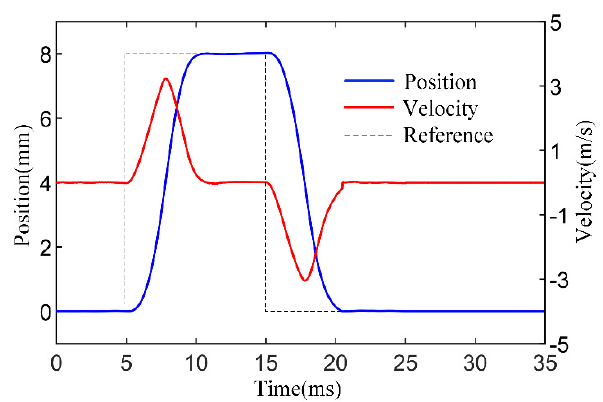
Figure 13. Position and velocity curve when lift is 8 mm.